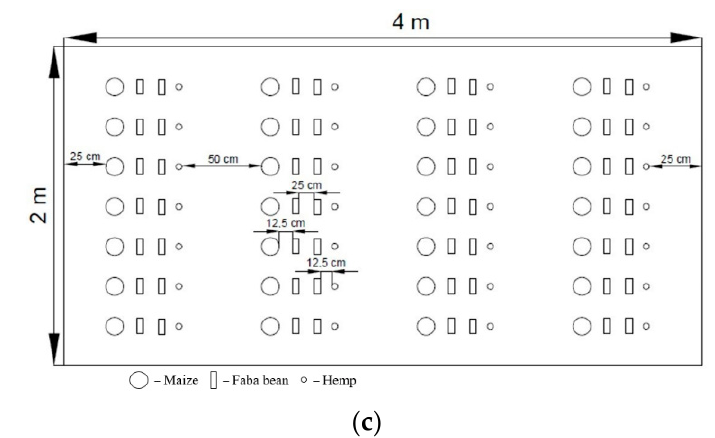
Figure 2. The sowing scheme of mono ( a ), binary ( b ) and ternary ( c ) cultivations.